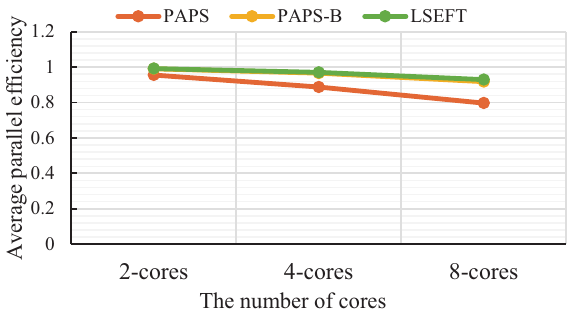
Figure 8. Average parallel efficiency with different scheduling